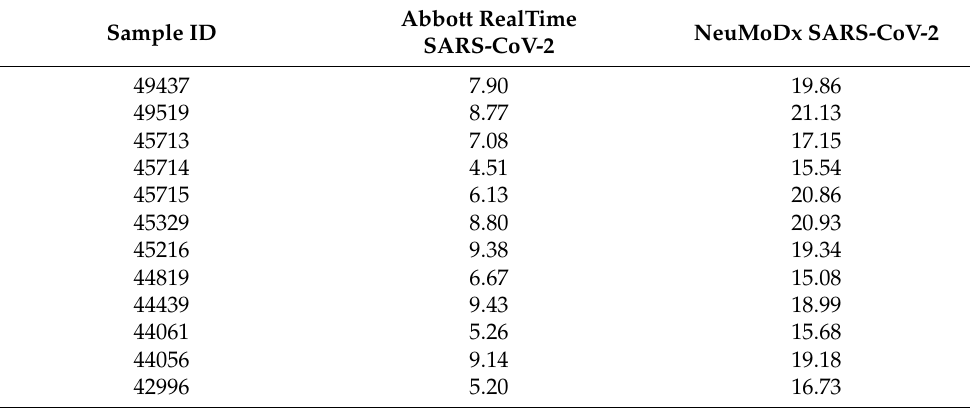
Table 3. Cycle threshold values of Abbott RealTime SARS-CoV-2 positive samples tested on